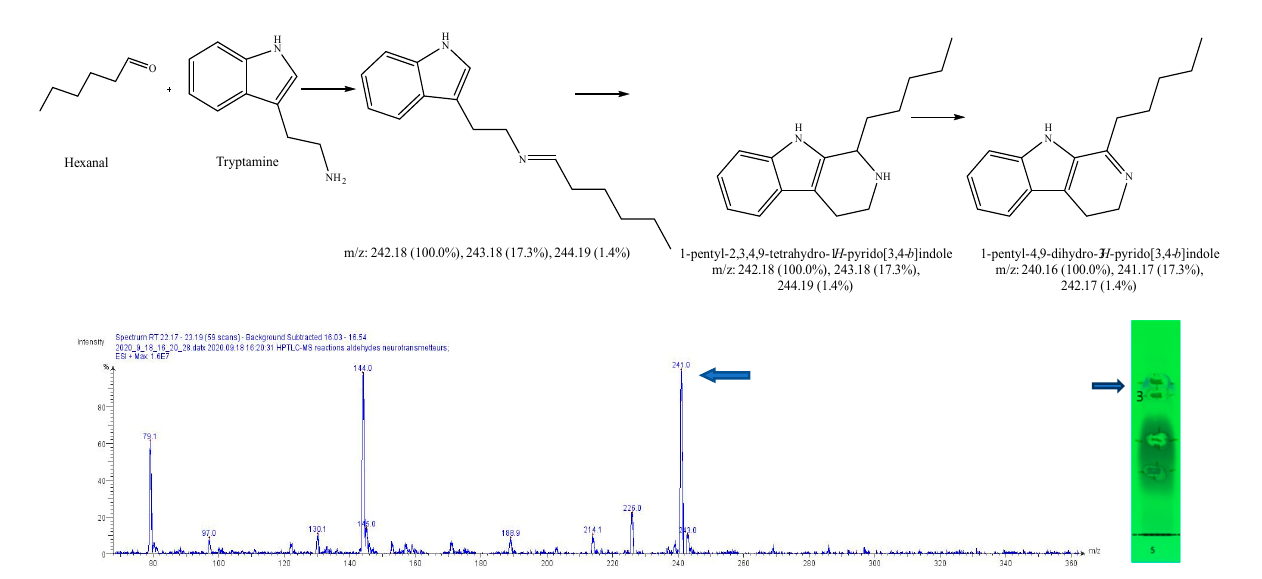
Figure 14. Expected reaction between tryptamine and hexanal. Mass spectrum for 3rd spot of the reaction mixture on MS grade TLC plate.